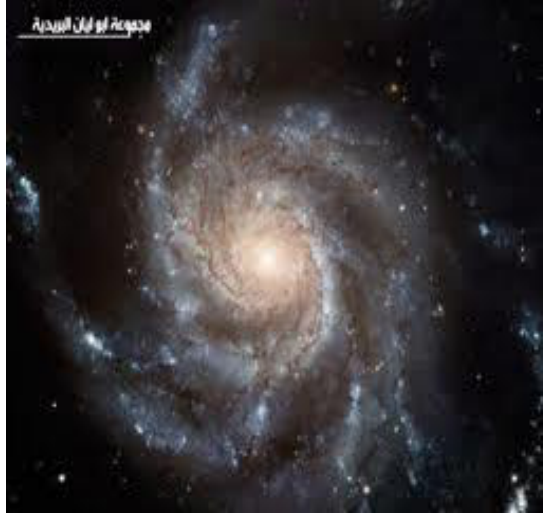
Fig.1: Original Milky way galaxy.